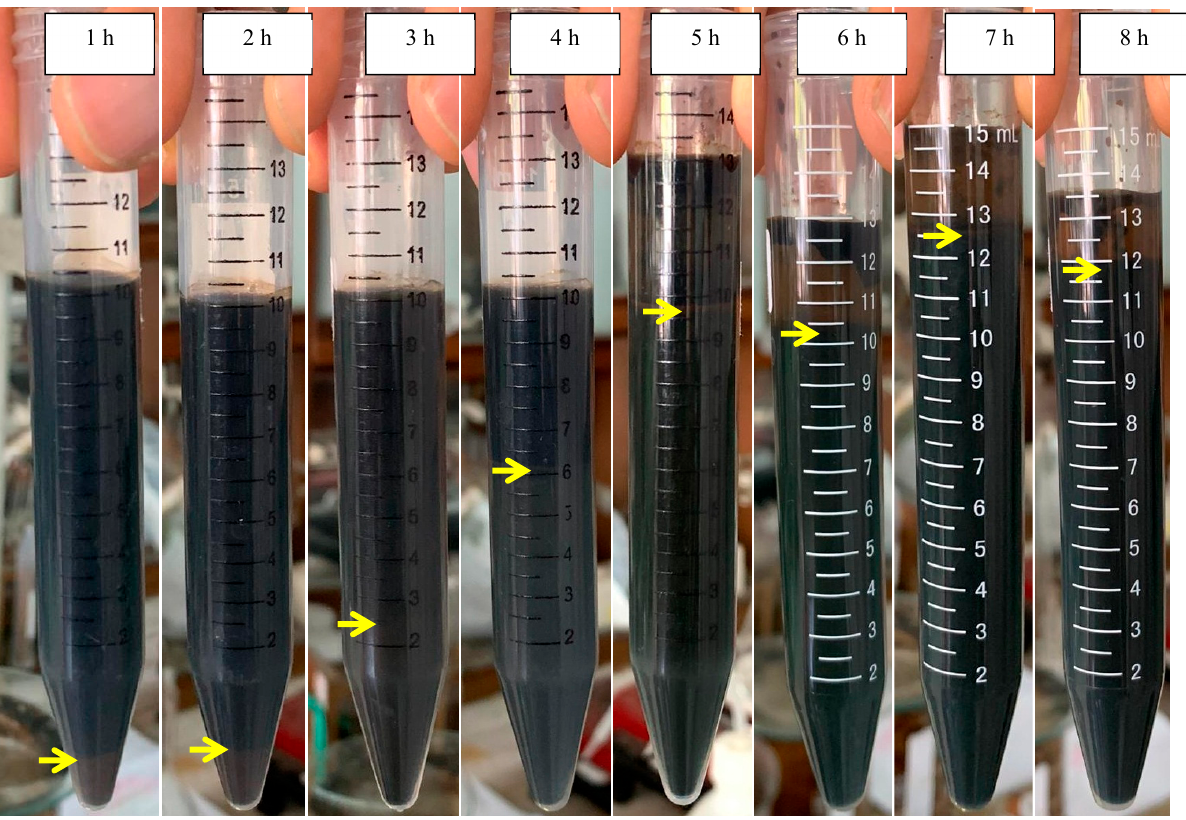
Figure 6. Settling at the initial pH of 5.